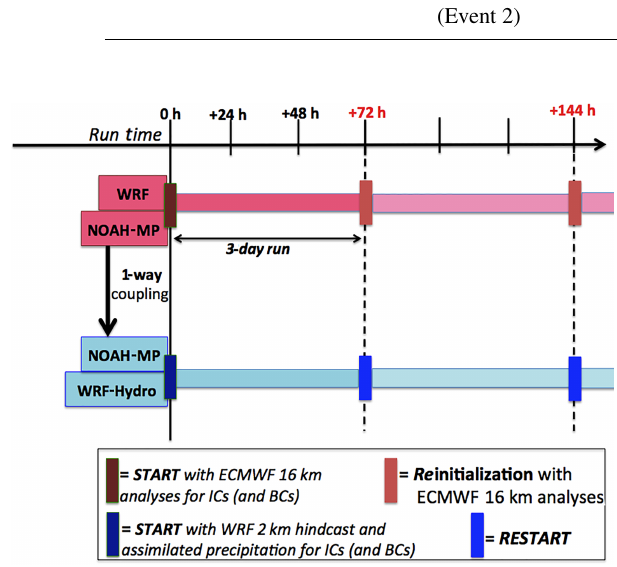
Figure 4. The concatenation procedure of the simulations.